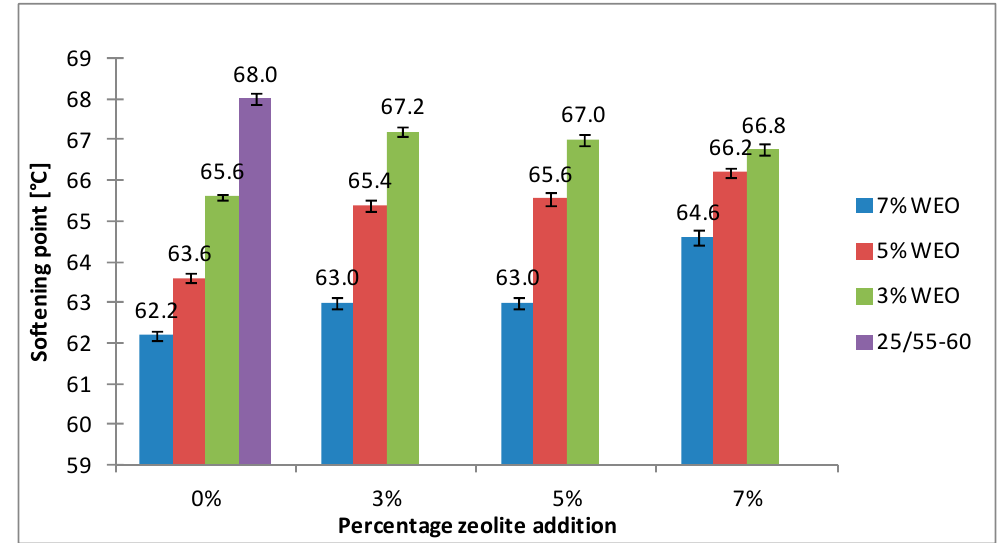
Figure 11. The results of softening point tests for the 25 / 55-60 asphalt with the addition of WEO and clinoptilolite zeolite.